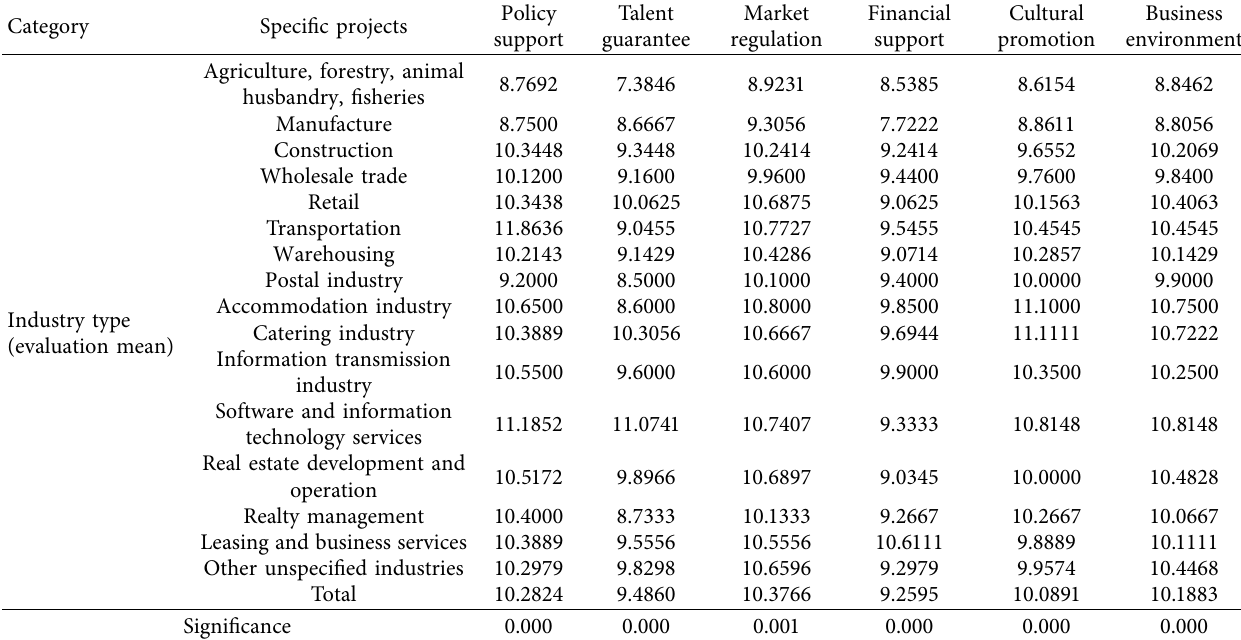
Table 4: One-Way ANOVA table for industry